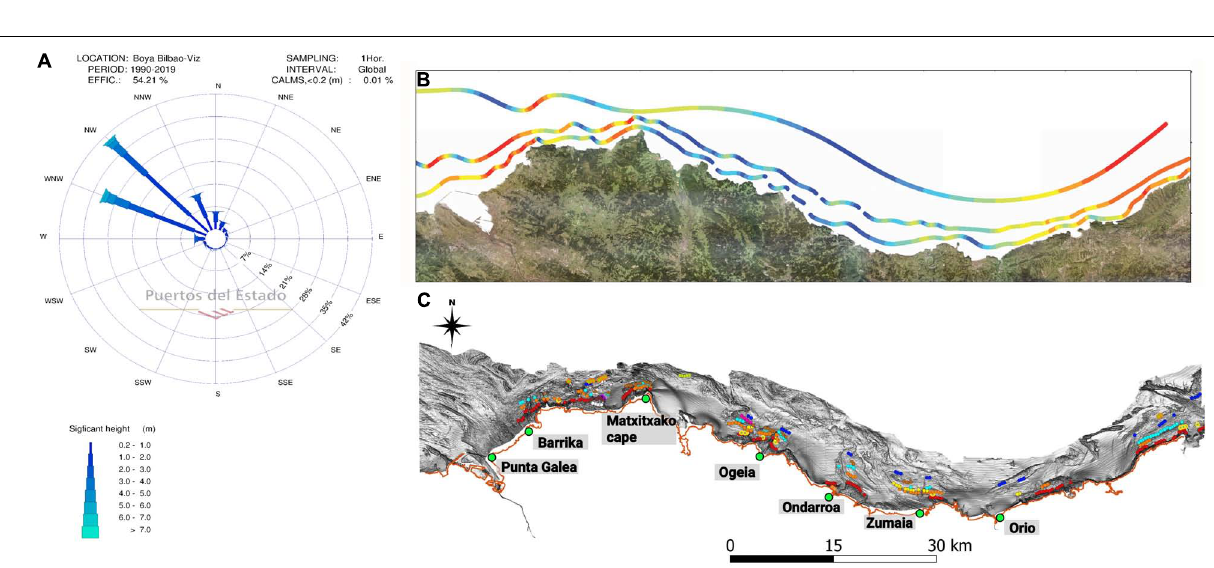
FIGURE 10 | Wave climatology and shoreline angles distribution. (A) Bilbao offshore buoy wave direction and height map (Boya de Bilbao-Vizcaya, 2019). (B) Annual power map from Galparsoro et al. (2008), which could be correlated with wave energy (red colors indicate highest power, and blue the lowest ones). (C) Distribution of detected shoreline